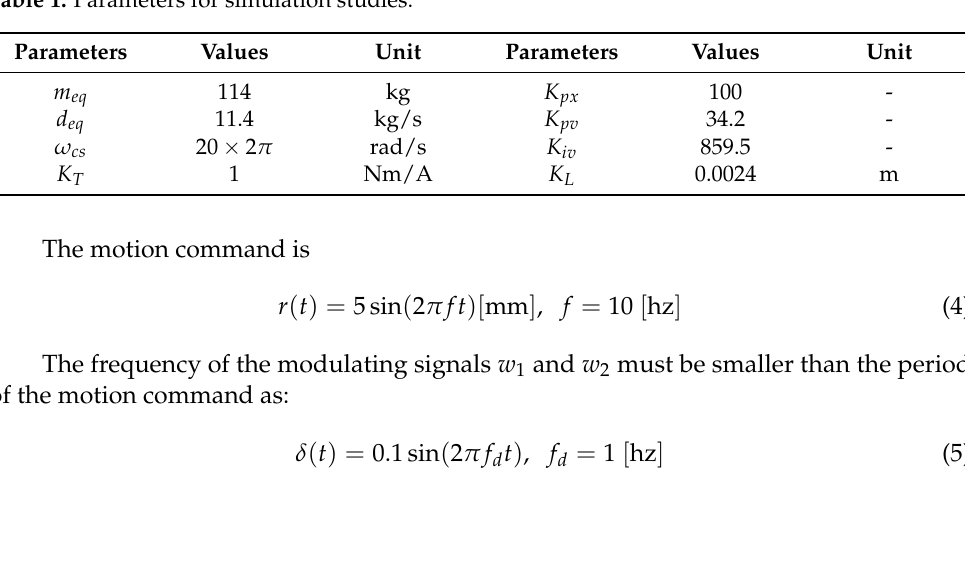
Figure 8. Examples of periodic weights: ( a ) Sinusoidal wave, ( b ) triangular wave. Table 1. Parameters for simulation